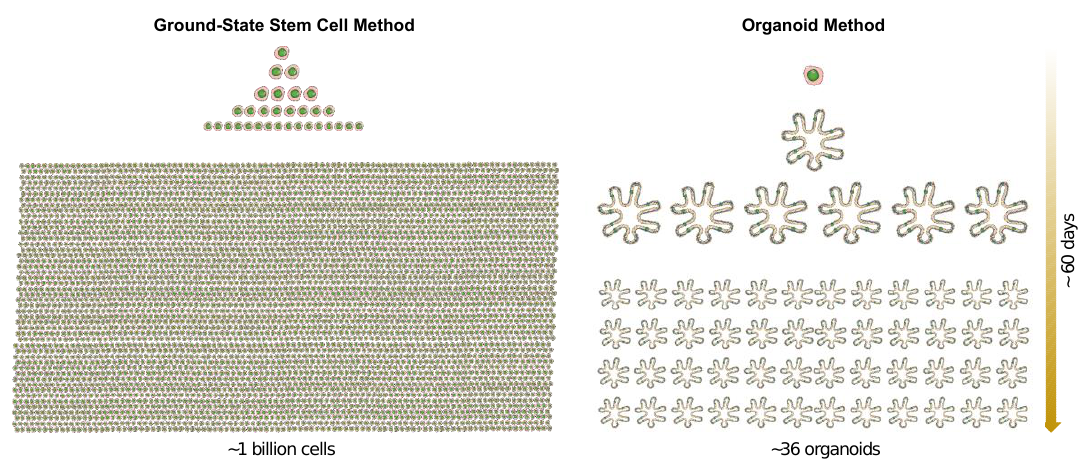
Figure 2. Rapid expansion of a single cell to one billion cells in approximately 60 days using the Xian–McKeon method. In comparison, one cell can become 36 organoids in the organoid method.